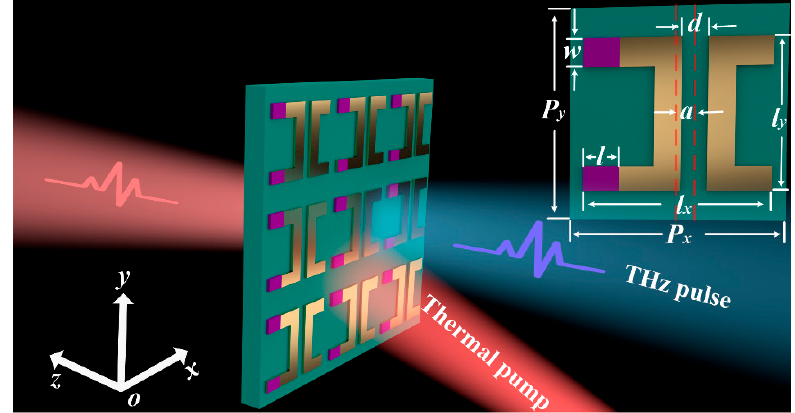
Figure 2. Graphical representation of the VO 2 -implanted terahertz (THz) asymmetric double C-shaped metamaterial (MM) sample under the thermal pump and THz pulse irradiation. The upper right inset shows the detailed geometry dimensions of the unit cell with period length Px = Py = 180 µ m, resonator length lx = 140 µ m and ly = 120 µ m, resonance linewidth w = 15 µ m, VO 2 rectangular strip length l = 32 µ m and gap d = 15 µ m, (asymmetric parameter) o ff set length a = 16 µ m